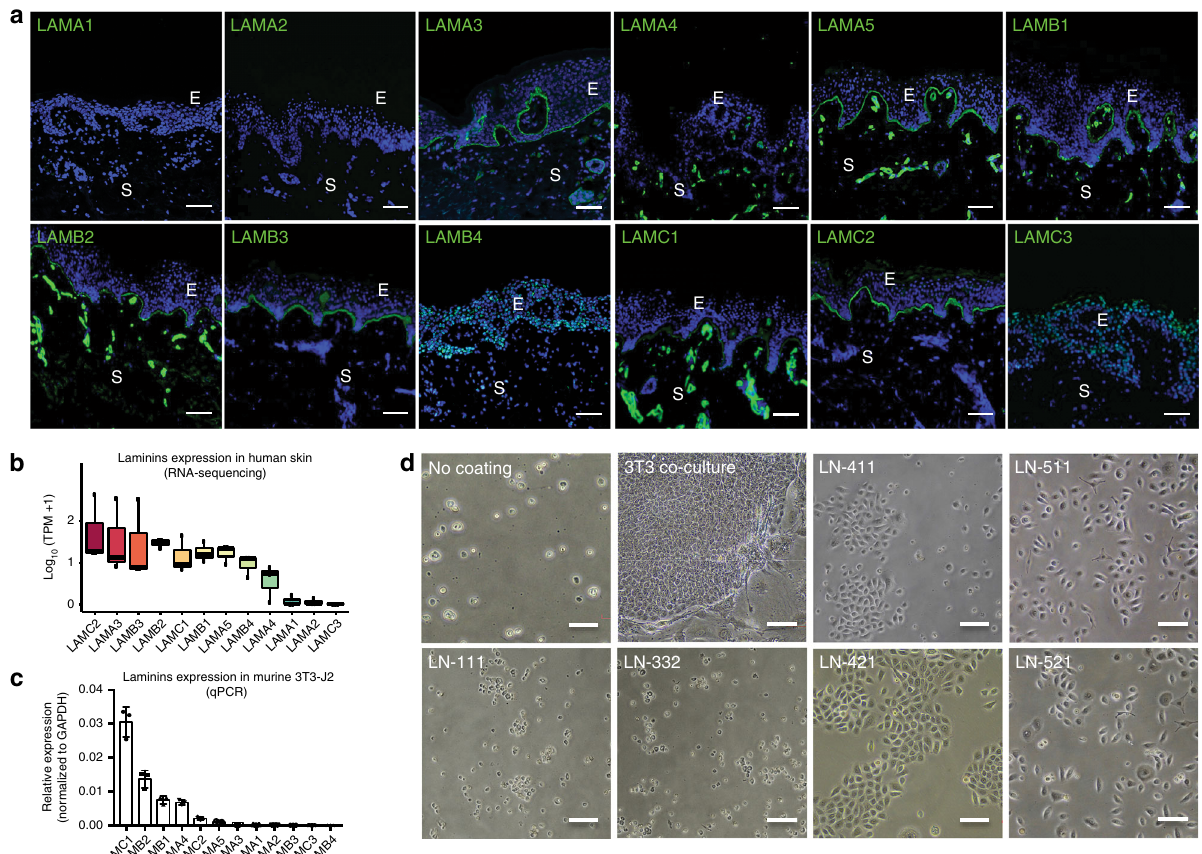
Fig. 1 Identi fi cation of laminin chain expression in human epidermal basement membrane. a Immuno fl uorescent staining of laminin isoforms in skin section. Laminin isoform stainings at human skin basement membrane showed positive for laminin α 3, α 5, β 1, β 2, β 3, γ 1, and γ 2 chain isoforms. The laminin α 4 chain was not present in the basement membrane but it stained positive on blood vessels. E epidermis, S stroma. Scale bar = 200 μ m. b Expression of laminin chains in human skin based on RNA-sequencing. c mRNA expression level of laminin chains expressed by 3T3-J2 obtained by real-time PCR. Only expression of laminin α 4, α 5 β 1, β 2, γ 1, and γ 2 chains were observed ( n = 3, error bar represents means ± s.e.m.) d Morphology of human epidermal keratinocytes cultured on various laminin matrices vs. controls (without coating/co-cultured with 3T3-J2 fi broblasts). Cells cultured on plastic only (control), LN-111 (Matrigel laminin), and LN-332 did not survive. Images were taken at day 7 post seeding. Scale bar = 100 μ